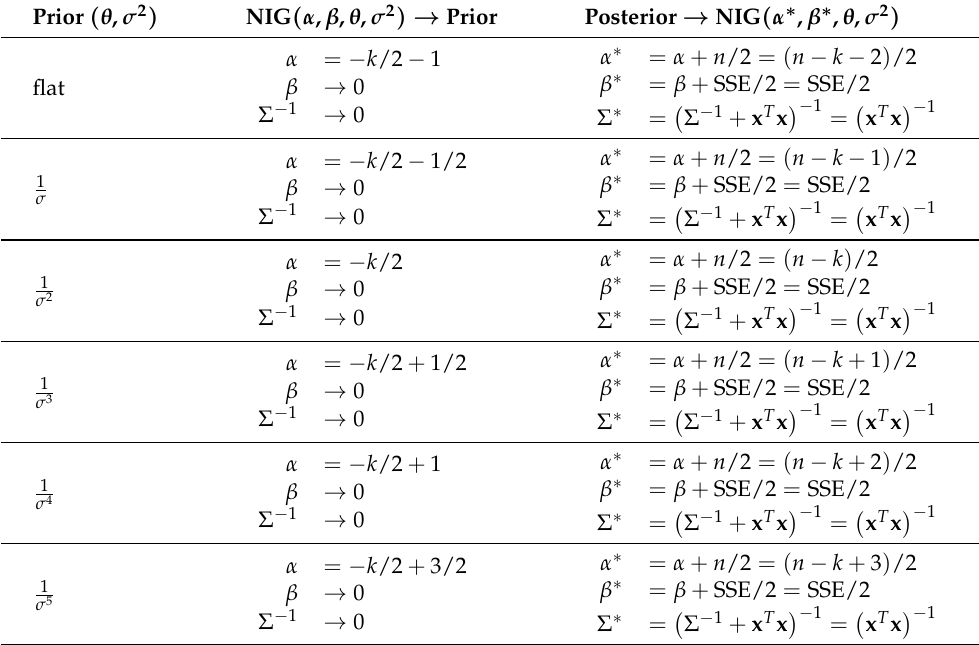
Table 1. 1/ σ q -type of prior as limiting state cases of the NIG distribution and its NIG posteriors. Prior ( θ , σ 2 ) NIG ( α , β , θ , σ 2 ) → Prior Posterior → NIG ( α ∗ , β ∗ , θ , σ 2 ) flat